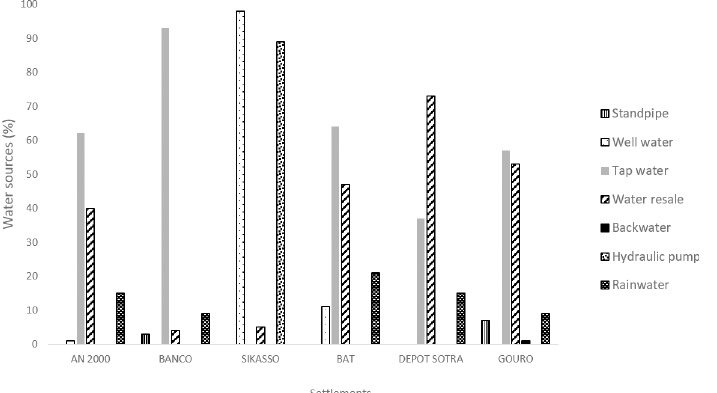
Fig 2. Water supply (%) in each settlement of the study